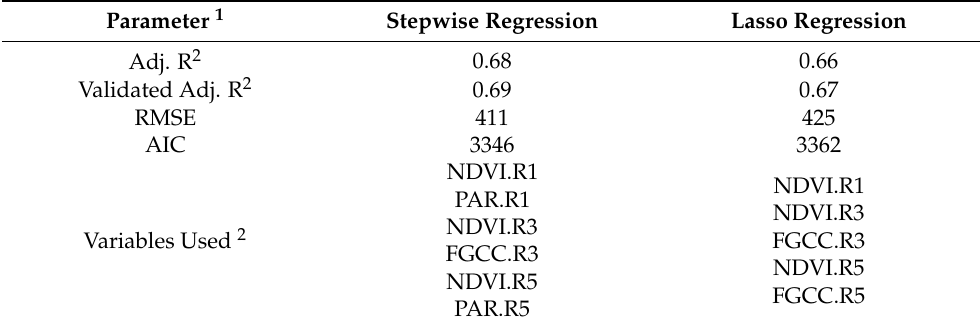
Table 4. Stepwise and Lasso regression parameter comparison for soybean canopy measurements combined across 12